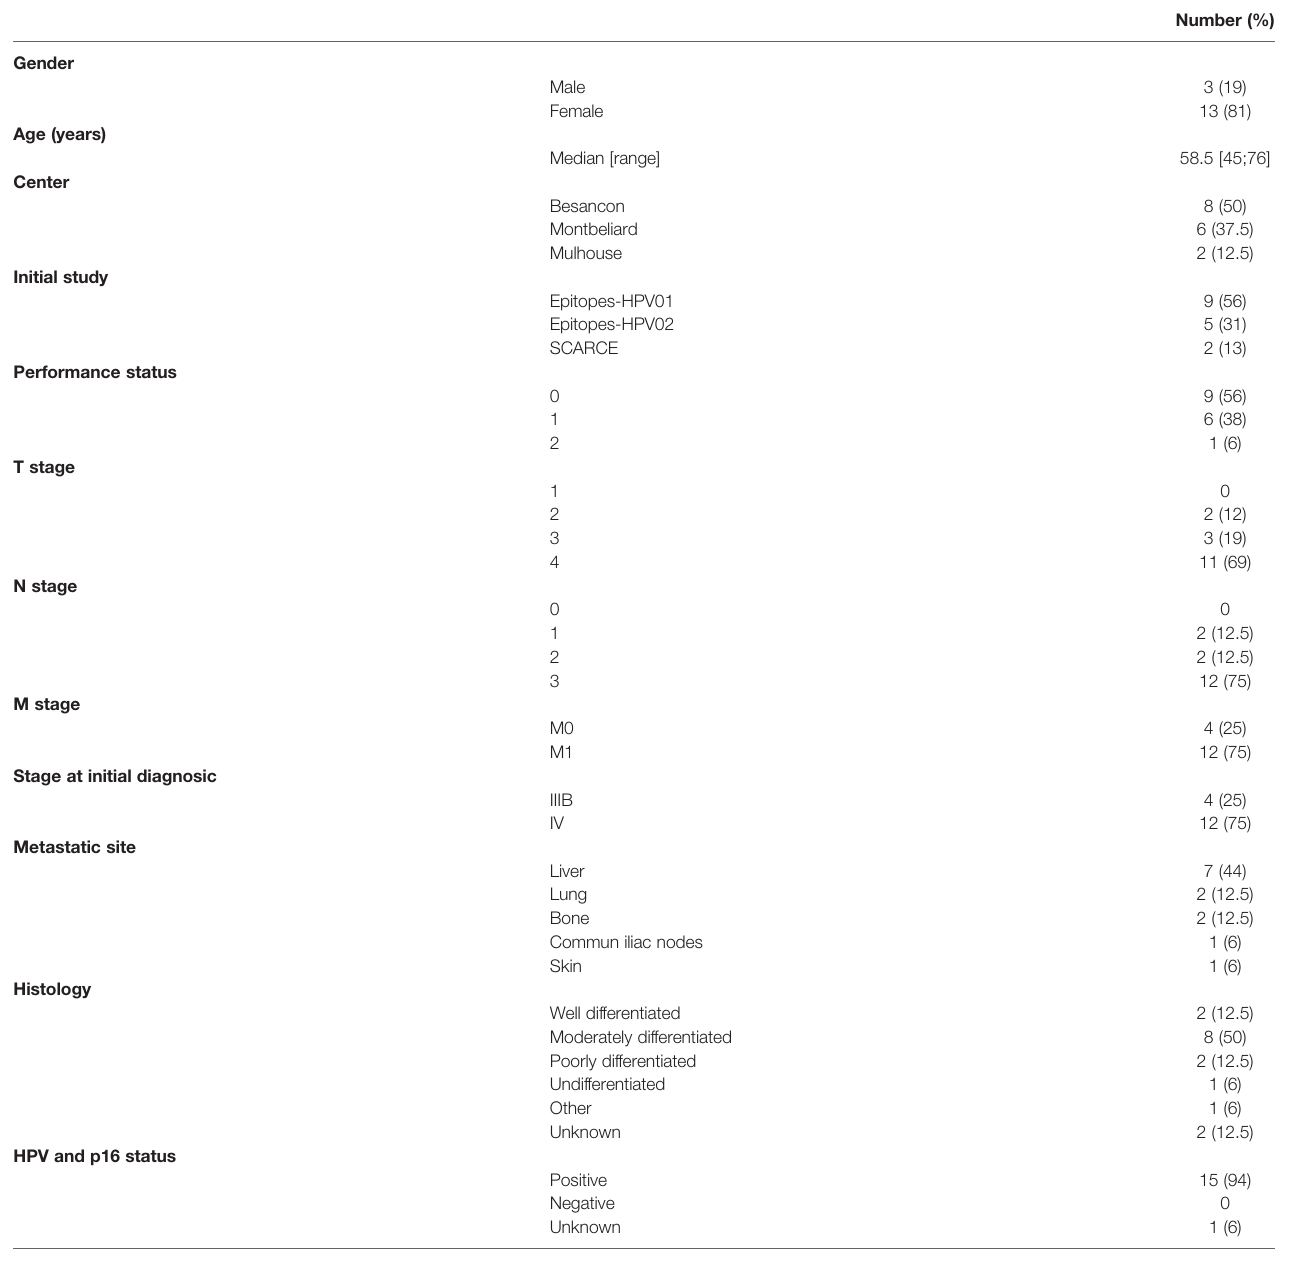
TABLE 1 | Patients ’